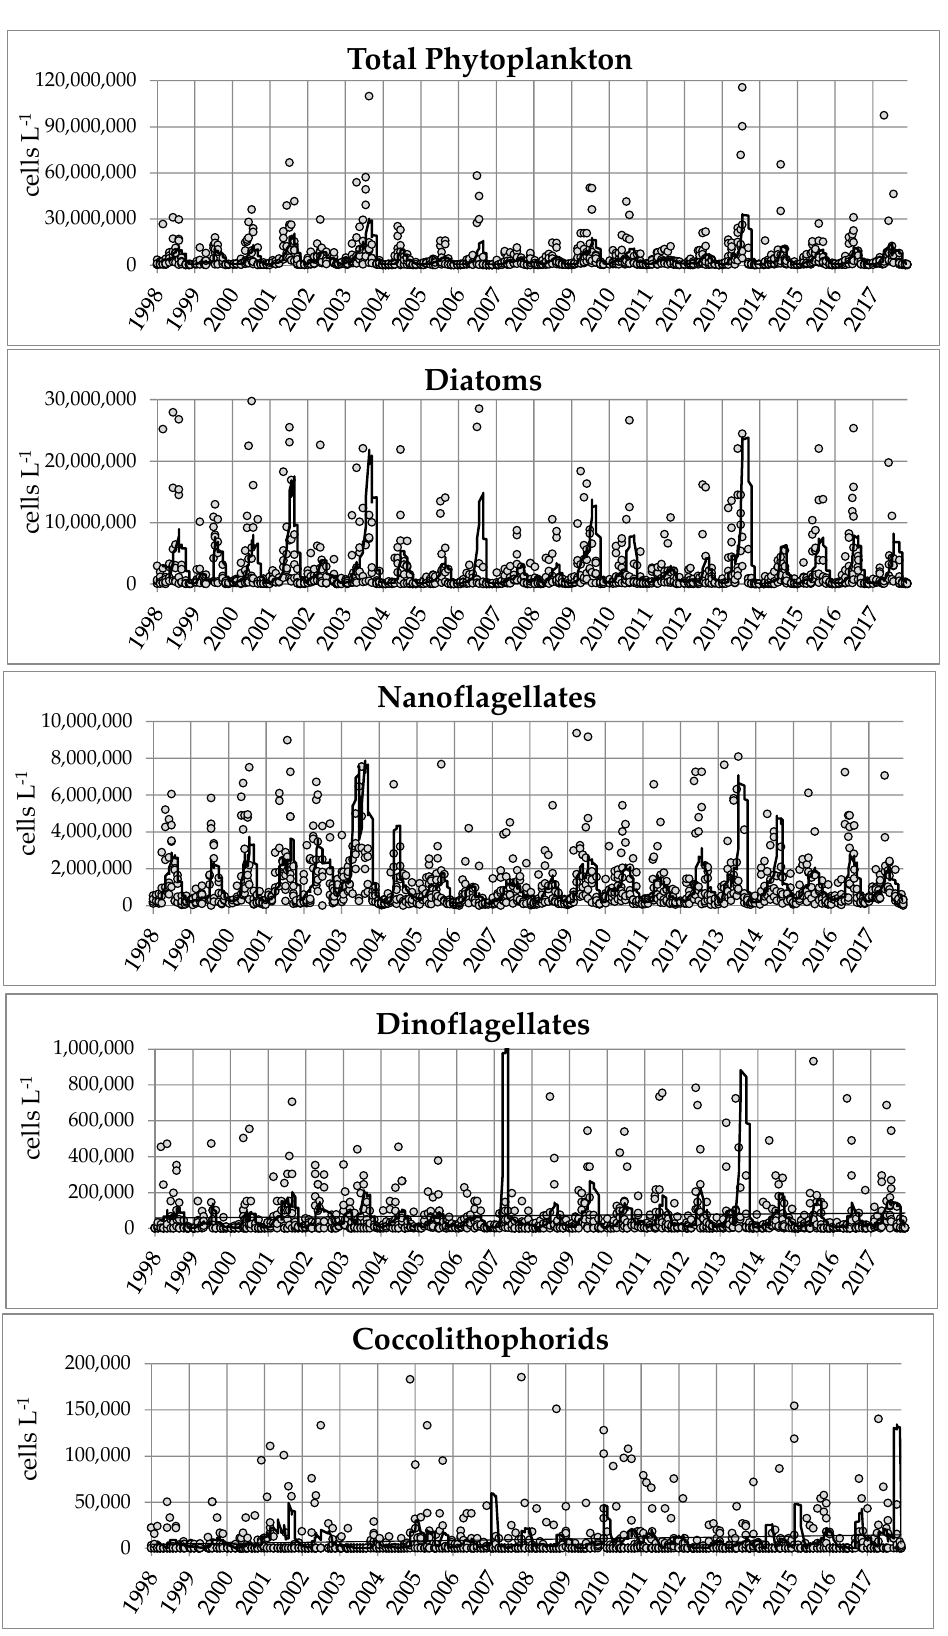
Figure 3. Multiannual variations in the abundance (moving average) of total phytoplankton and of the main phytoplankton groups (points = samples; line = moving average).